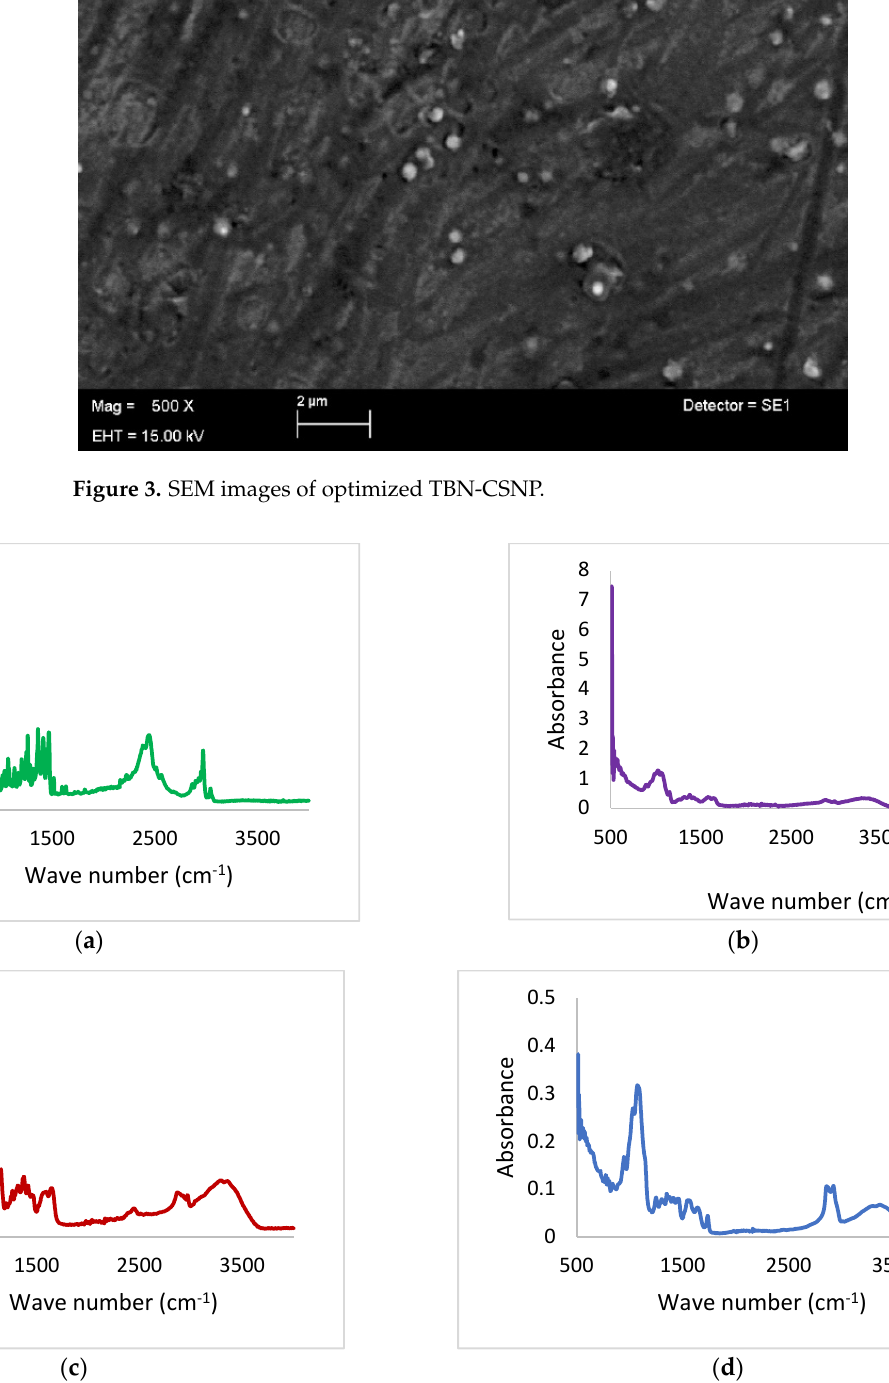
Figure 3. SEM images of optimized TBN-CSNP.